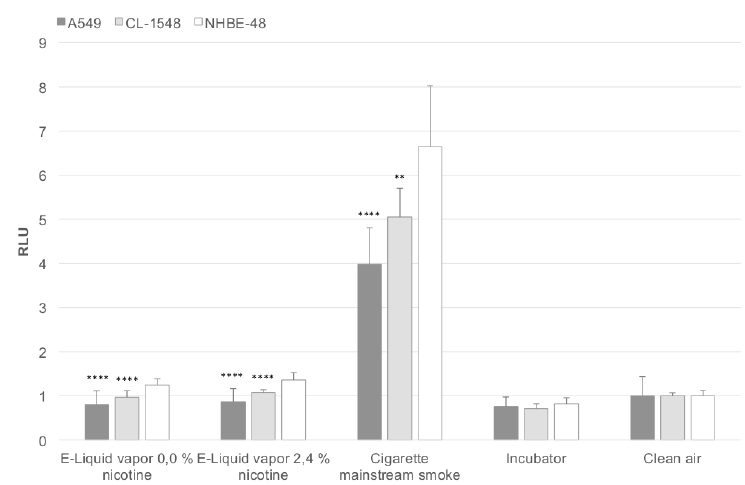
Figure 2. Puff-adjusted values for the oxidative stress level after exposure. The results are normalized to the clean air control and are given as a mean of five (NHBE48) and three (CL-1548, A549) independent experiments with three samples each + standard deviation. The asterisks indicate the statistical significance compared to NHBE48 cells. The relevance of the significance is explained in Section